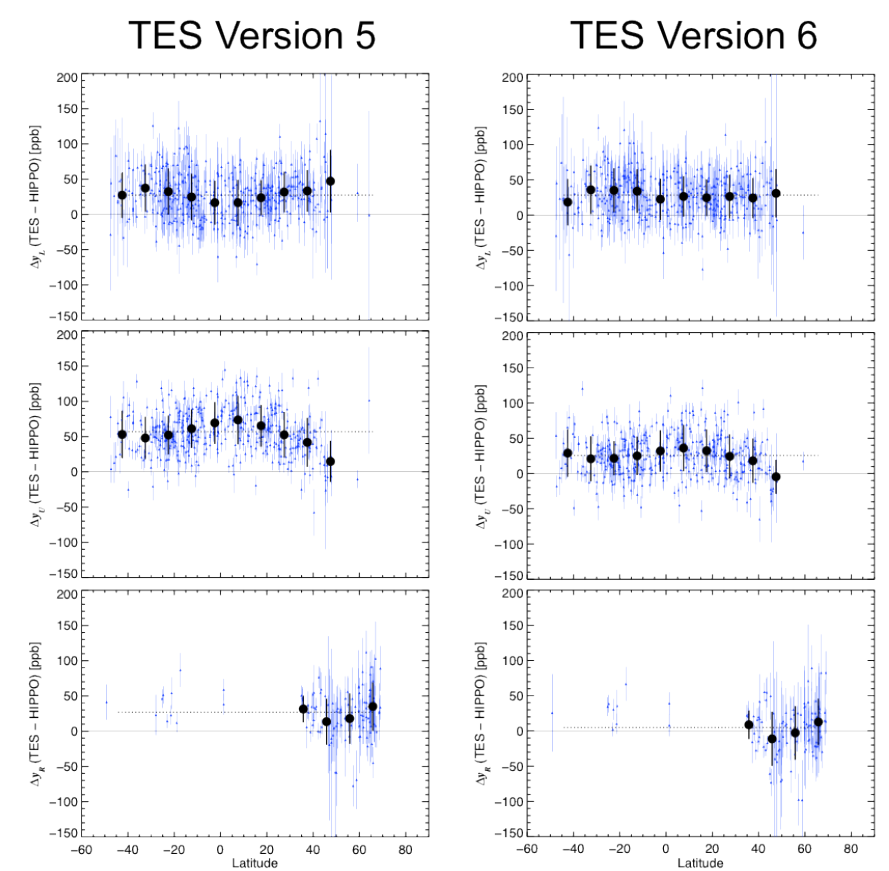
Figure 5. As in Fig. 4, but for the N 2 O-corrected TES CH 4 retrievals (see Eq. (5) and Worden et al., 2012). Table 3. Mean bias ( ± 1 σ , in ppb) of the lower ( y L ) and upper ( y U ) troposphere RTVMR for TES CH 4 retrievals with DOFS ≥ 1.6 and overall RTVMR ( y R ) for retrievals with DOFS <